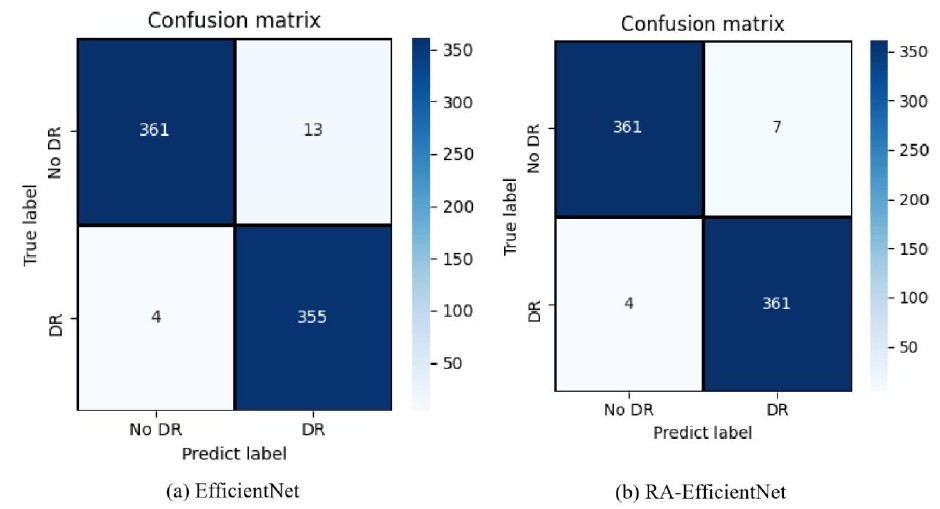
Figure 8. Confusion matrix of EfficientNet and RA-EfficientNet for task 1.